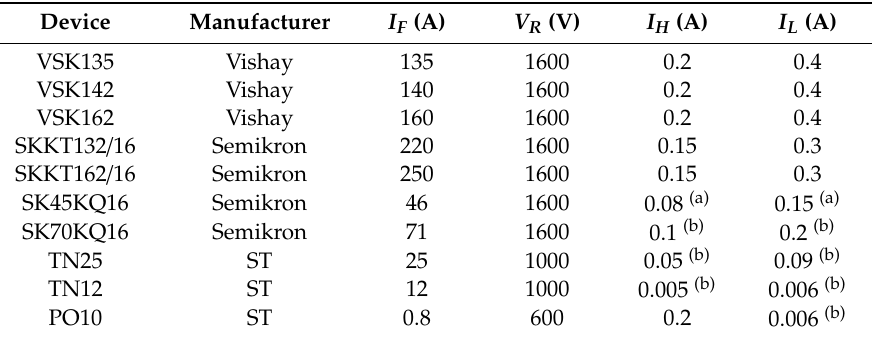
Table 1. Examples of SCR characteristics.